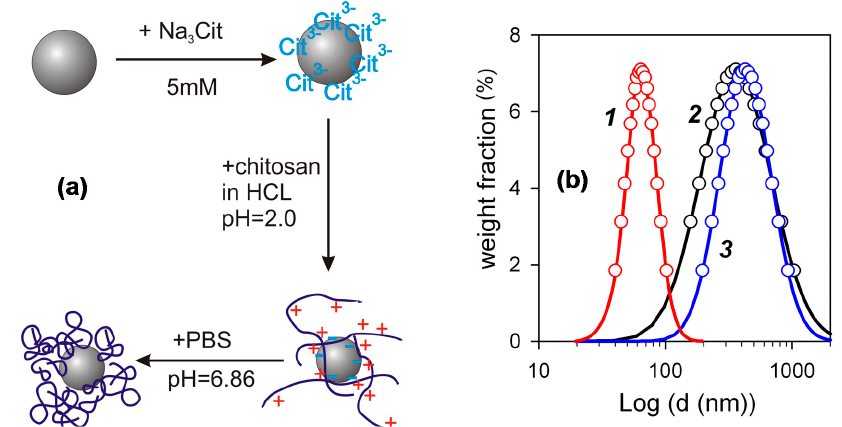
Figure 4. ( a )—Scheme of encapsulation of iron oxide MNPs by chitosan. ( b )—PSD (obtained by